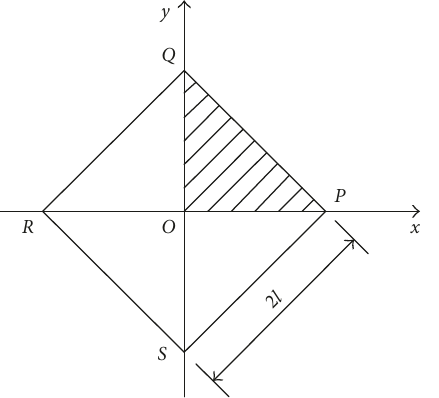
Figure 3: Structural diagram of the plate.